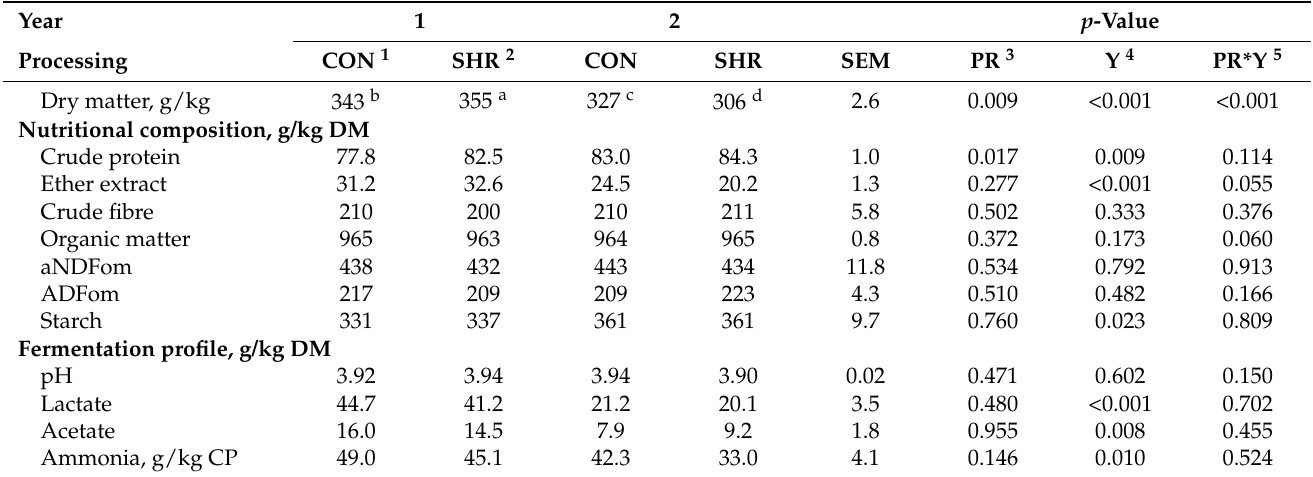
Table 1. Chemical composition and fermentation profiles of maize silages harvested using conven- tional or shredlage